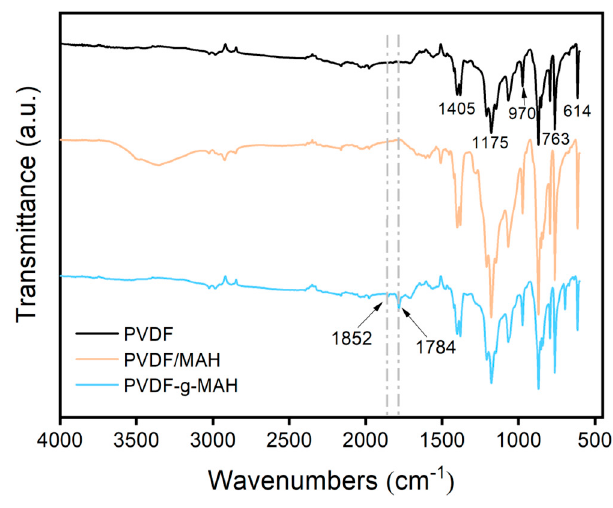
Figure 1. FTIR spectra of pure PVDF, PVDF/MAH and PVDF-g-MAH (G = 0.63%).